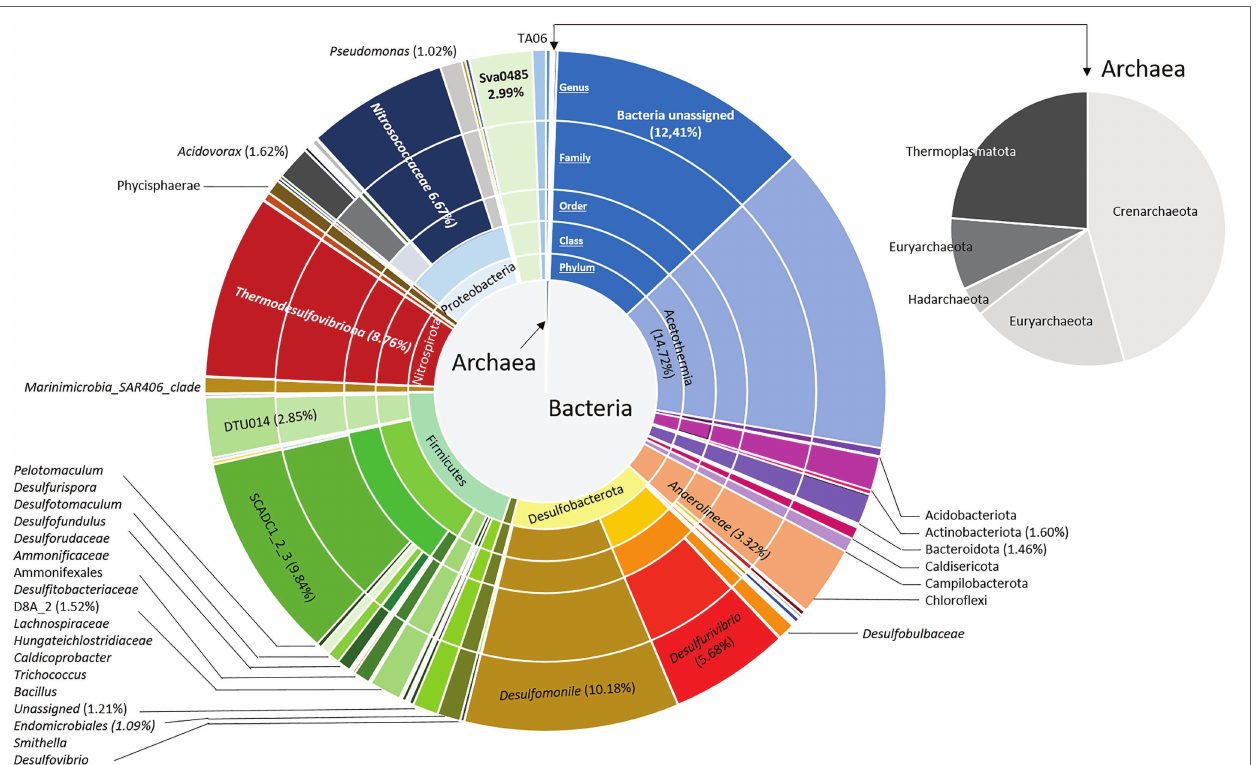
FIGURE 1 | Bacterial and archaeal community composition in the formation water from a deep aquifer used for natural gas storage (Pb_J_6, Parisian sedimentary basin). Based on the V4 region of the 16S SSU rRNA, the pie charts represent the relative abundance as the percentage of each taxon with the interior toward the periphery: phylum, class, family, and